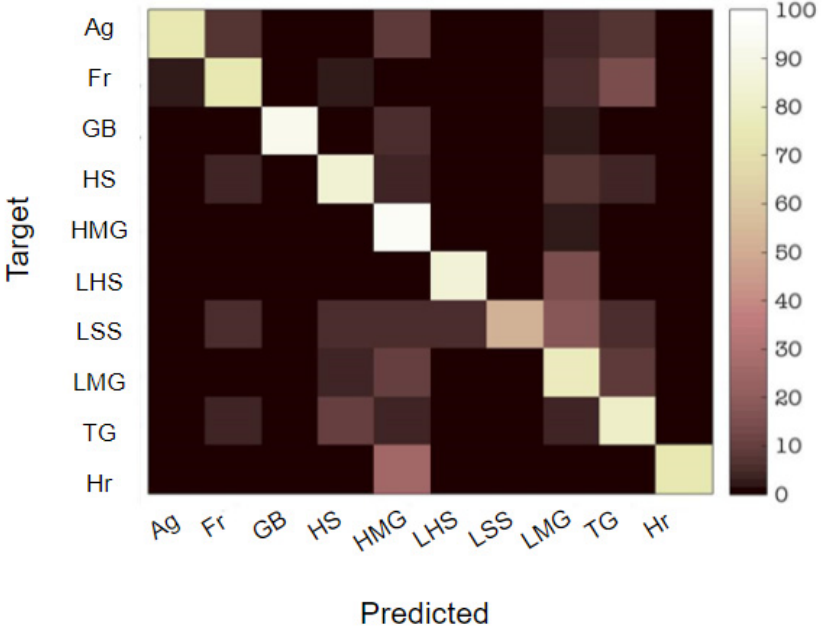
Figure 8. Producer’s accuracy obtained with SSLES. The colours illustrate the accuracy, where white colour represents 100% accuracy, and black represents 0% accuracy.